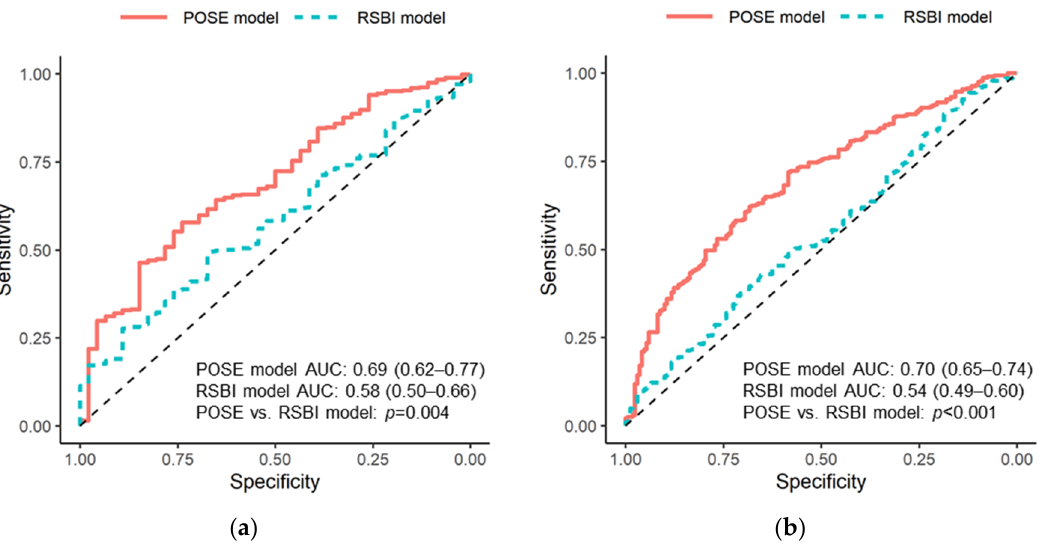
Figure 3. Receiver operating characteristic curves for the prediction models. The receiver operating characteristic curves for successful extubation ( a ) and uneventful extubation ( b ) for models based on eight predefined physiological factors (POSE model) and RSBI alone (RSBI model). The AUCs are shown for each model, and the p -values represent the intergroup differences. POSE, Prediction of Successful Extubation; AUC, area under the receiver operating characteristic curve; RSBI, rapid shallow breathing index.